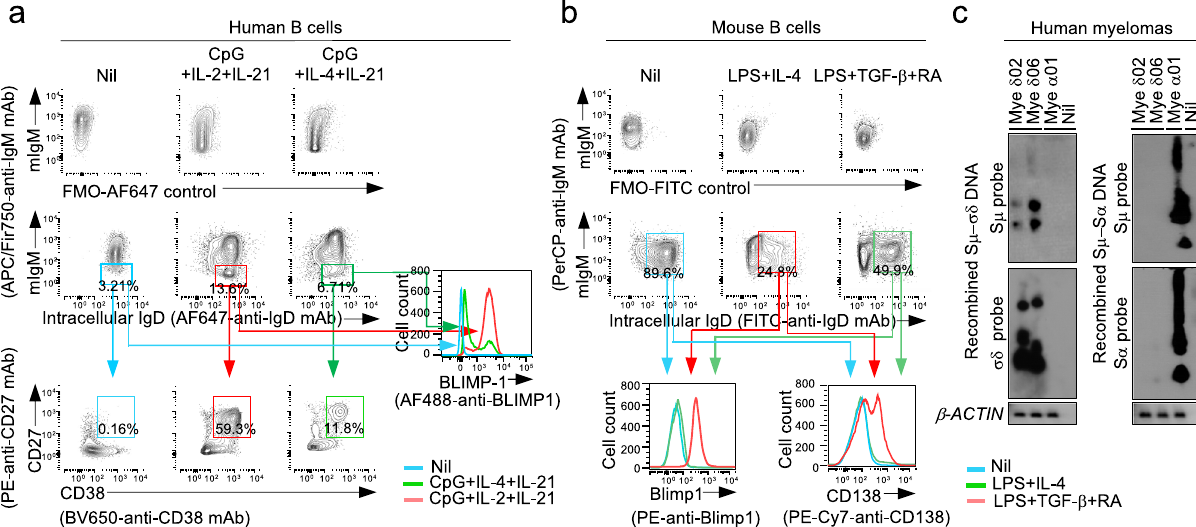
Fig. 9 B cells undergoing CSR to IgD differentiate to IgD-producing plasmablasts/plasma cells. a Human blood naive IgM + IgD + B cells were stimulated with CpG plus IL-2 and IL-21, which induce IgD CSR, or CpG plus IL-4 and IL-21, which do not induce IgD CSR. Proportions of CD138 + IgM − IgD + plasmablasts/plasma cells among intracellular sIgM − IgD + B cells and BLIMP-1 expression in intracellular sIgM – IgD + cells, as analyzed 120 h post- stimulation by fl ow cytometry. Alexa Fluor 647- fl uorescence minus one (FMO) controls are shown as reference. b Mouse Rad52 + / + B cells and Rad52 − / − B cells stimulated with LPS plus IL-4, which induce IgD CSR. Proportions of sCD138 + plasmablasts/plasma cells among intracellular IgD + sIgM − cells and Blimp-1 expression in intracellular IgD + sIgM − cells, as analyzed 96 h post-stimulation by fl ow cytometry. FITC-FMO controls are shown as reference. Data in a and b are representative of three independent experiments. c Recombined S μ – σδ and S μ – S α DNA in two IgD + myelomas and one IgA + myeloma, as analyzed by speci fi c nested PCR followed by Southern-blotting using indicated